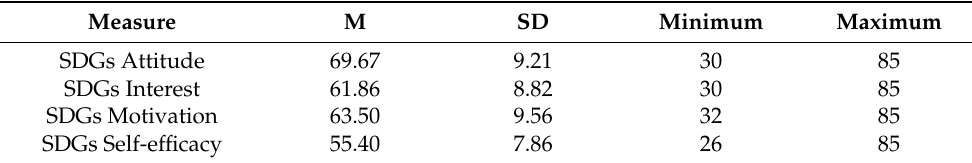
Table 5. Means and standard deviations for each dimension.